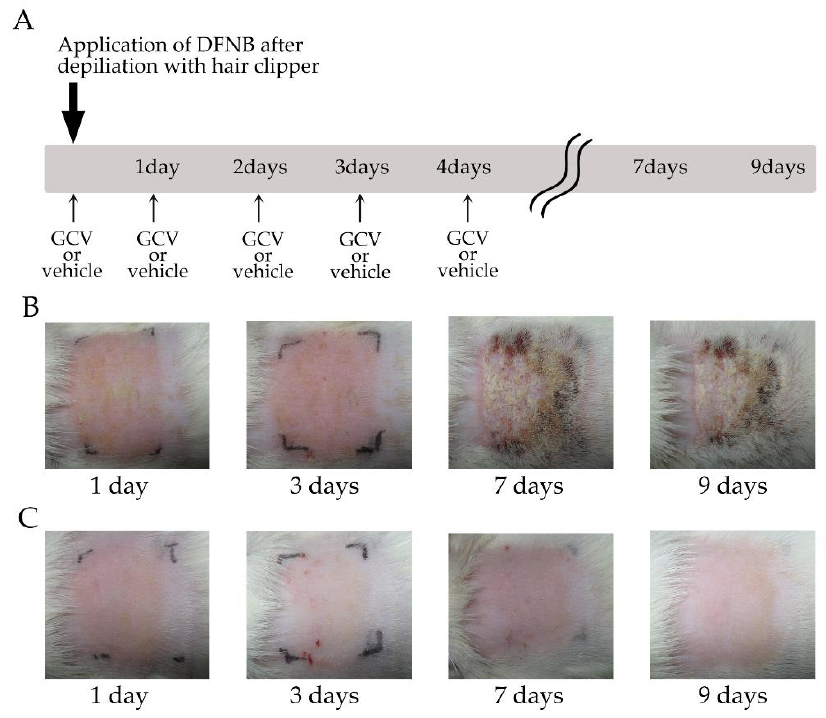
Figure 6. Selective elimination of NG2 + HFSCs during the depilation-induced anagen stage exacerbated the sensitization phase of contact dermatitis under exposure of DNFB. ( A ) Schematic of the experimental protocol. The bold arrow indicates depilation with hair clippers and application of 0.5% DNFB solution. Arrows show application of GCV or vehicle to defined area (black lines) of the Tg rat skin. GCV, ganciclovir. ( B , C ) Photographs of GCV-applied ( B ) and vehicle-treated ( C ) skin of Tg rats at 1, 3, 7, and 9 days after treatment of DNFB. Table 2. E ff ects of NG2 + HFSCs cell ablation on DNFB-induced contact dermatitis. Redness More Severe DNFB (Erythema) (Dry, Cracked, Scaly, Skin) GCV group + 4 / 4 4 / 4 Vehi group + 4 / 4 0 / 4